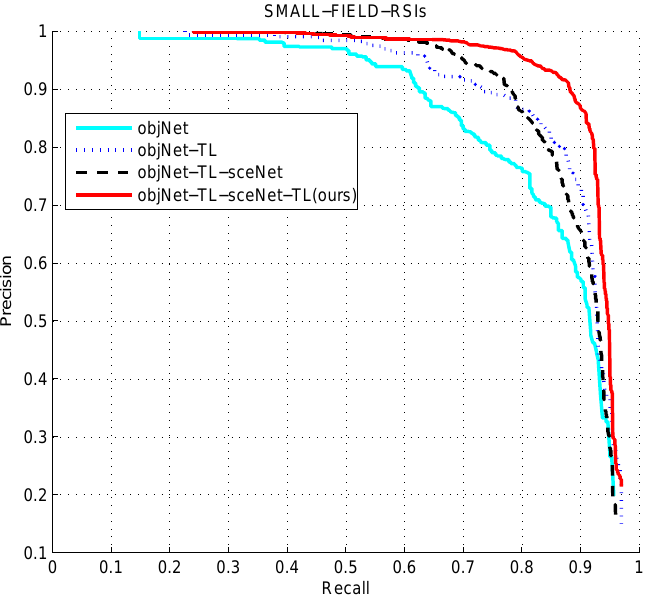
Figure 19. The performance comparison of four experiments on the SMALL-FIELD-RSIs